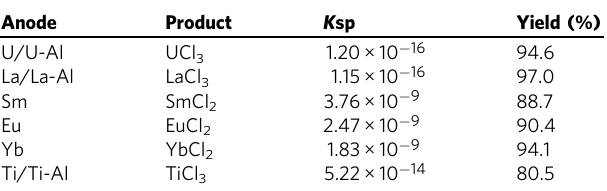
Table 1 K sp and recovery yields analyses of several different anodes for IAP in NaAlCl 4 molten salt electrolyte at 453